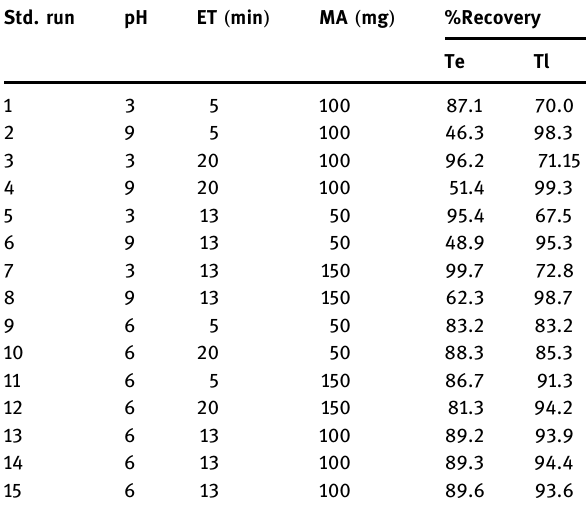
Table 3: Design matrix with a percentage of recoveries Std. run